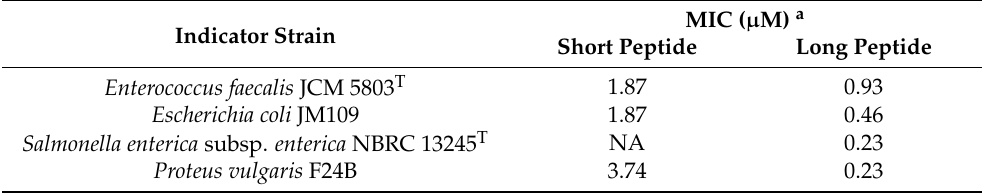
Table 3. Antimicrobial spectrum of the purified short and long